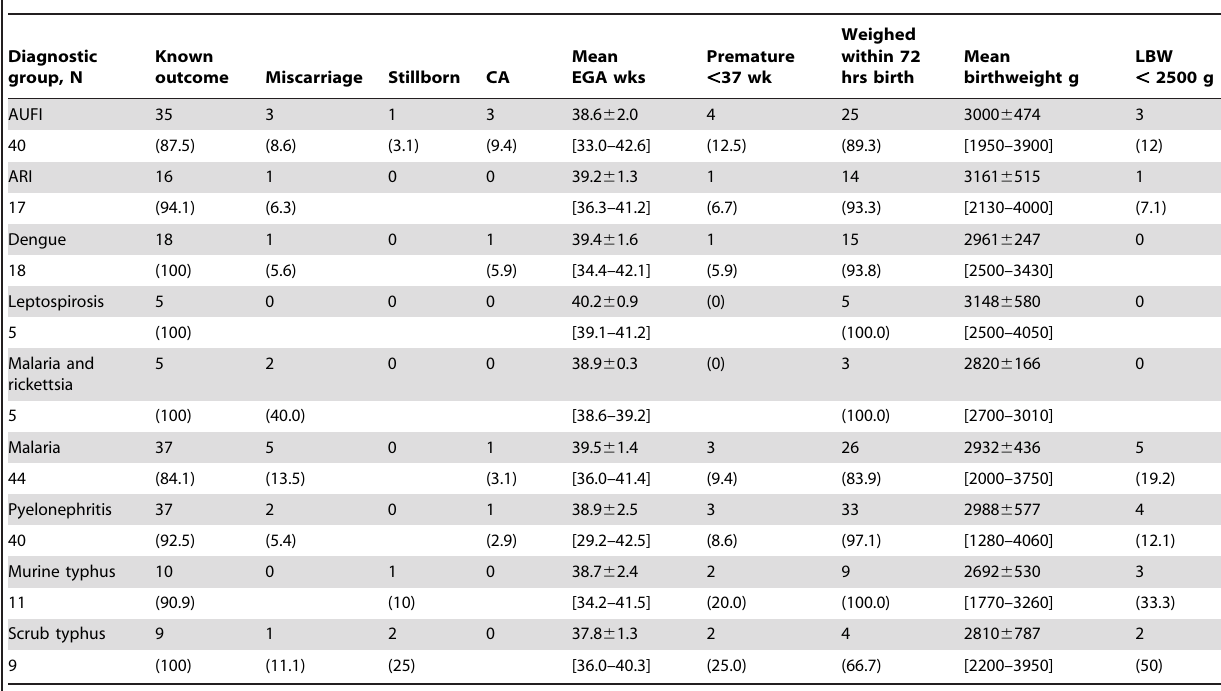
Table 4. Outcome of pregnancy in selected diagnostic groups.